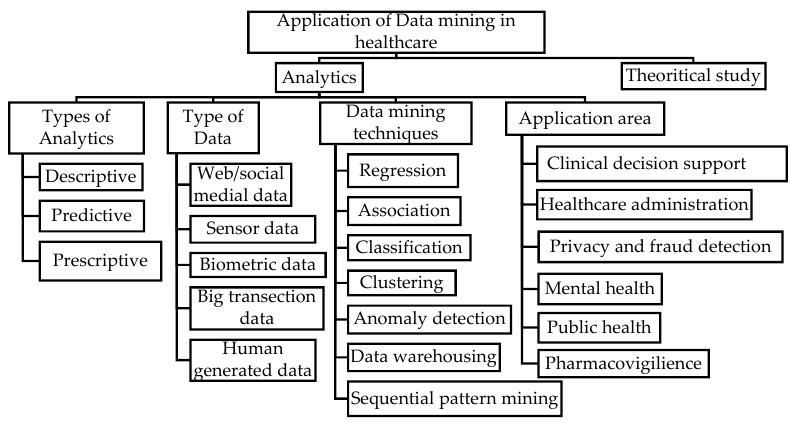
Figure 3. Classification scheme of the literature. Table 3. Operational definition of the classes.